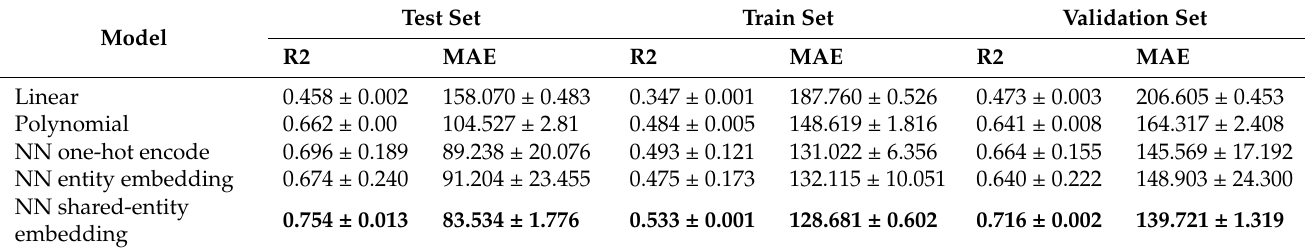
Table 7. Model performance without using the sheeting-grade as feature.The best performing models are in bold. Test Model